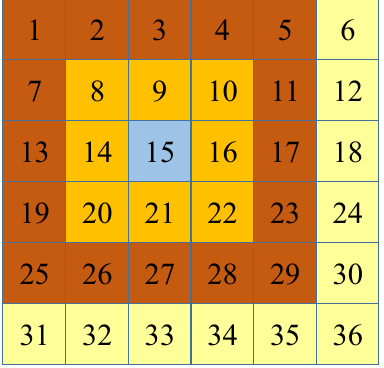
Figure 5. Finding the nearest not-traversed point (The blue block is the starting point, and the orange,